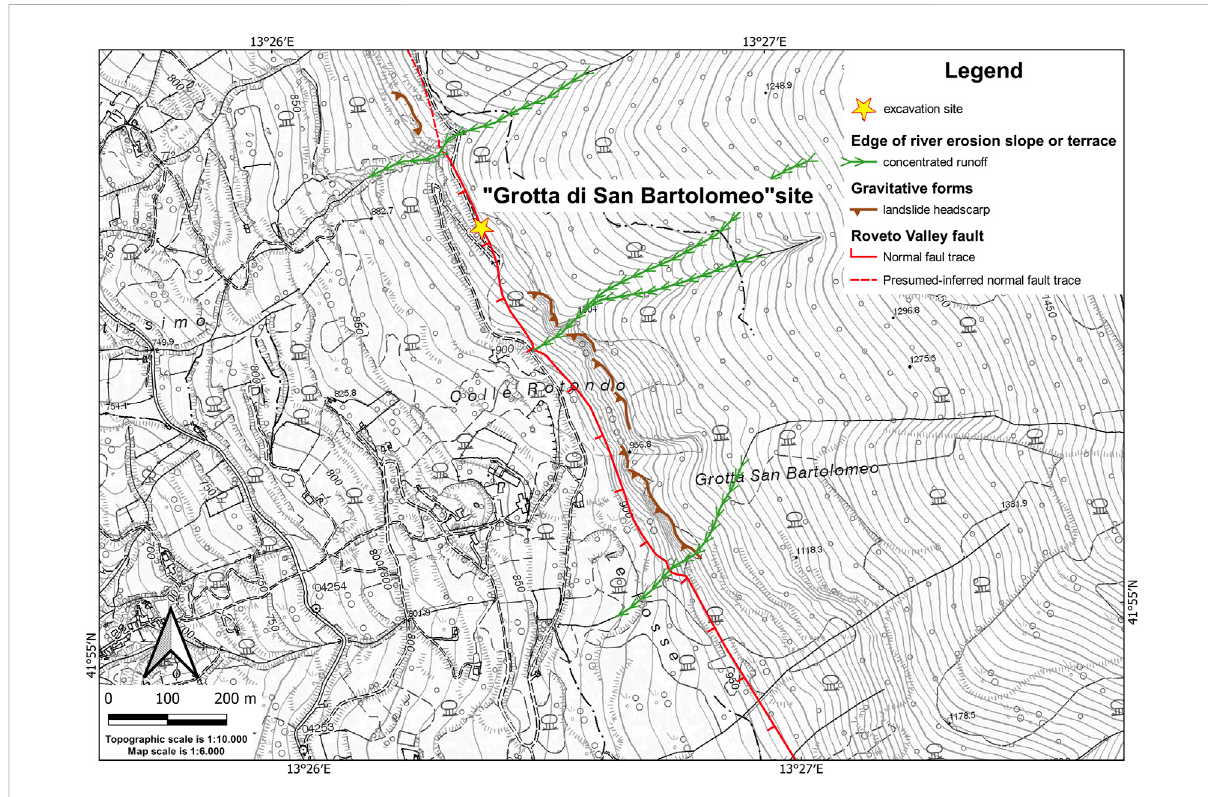
FIGURE 12 Geomorphologic scheme of the “ Grotta di San Bartolomeo ” site. Topographic map (scale 1:10.000) from opengeodata of the Abruzzi Region